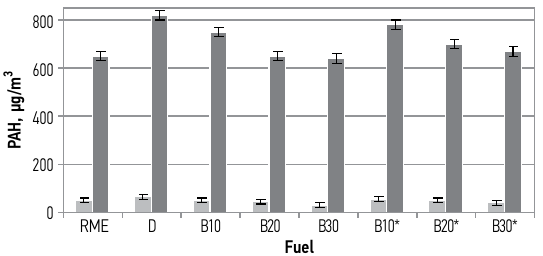
Fig. 5 . The dependence of the Bosch smoke index on fuel composition at the engine rotation speeds